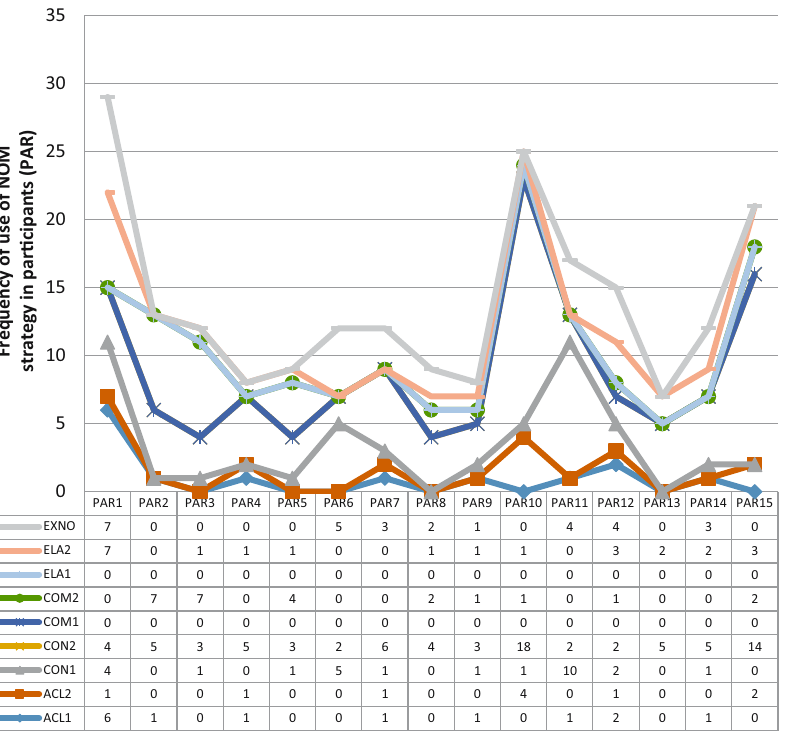
Figure 2: NOM strategies used by participants ( candidates ) in the oral test of LETRA